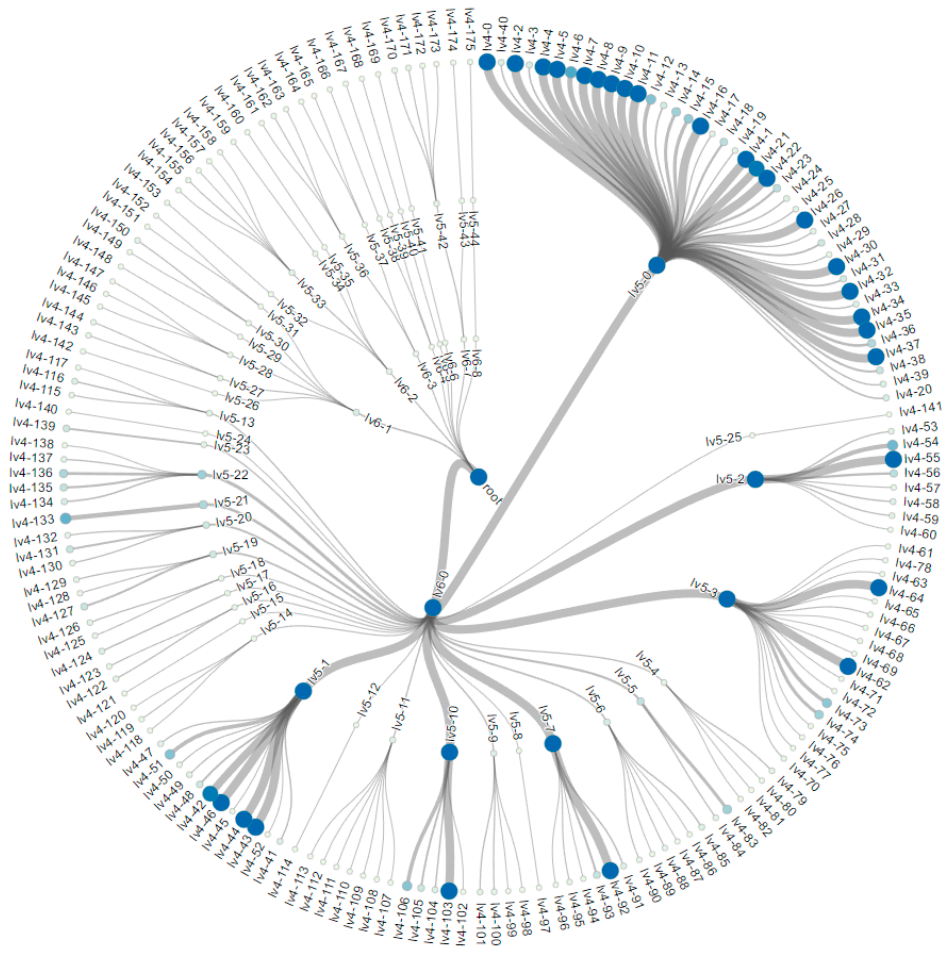
Figure 9. The extended circular dendrogram visualizing the hierarchy constructed from the Aerosol dataset.